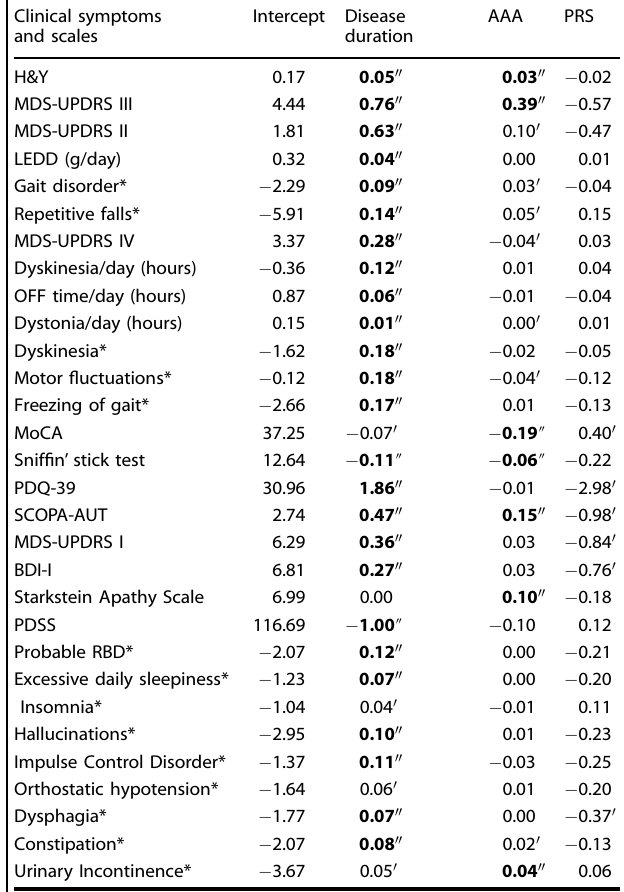
Single and double ticks indicate signi fi cance at the 5% level and the Bonferroni adjusted 5% level, the bold indicates signi fi cant effect where minus value indicates negative signi fi cant effect and positive value positive signi fi cant effect respectively. The binary variables are annotated by asterisk. Clinical symptoms and scales are described in Supplementary